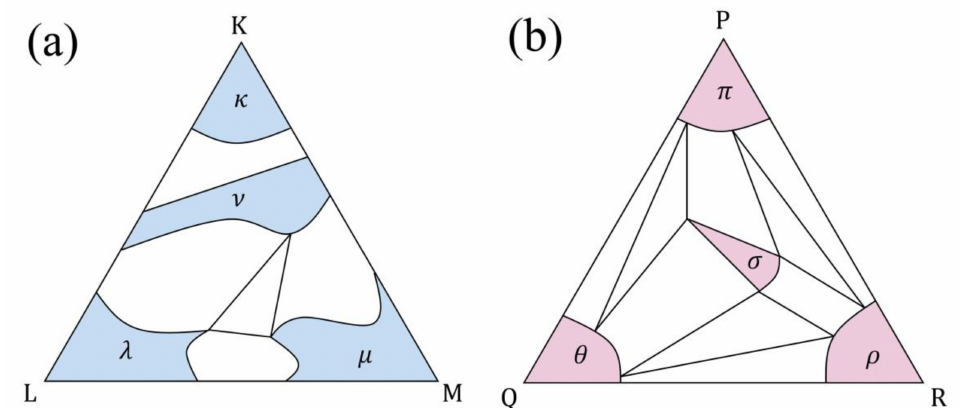
Figure 4. Imaginary phase diagrams illustrating the inheritance of IM phases in ternary systems. Colored areas represent single phase regions. ( a ) A phase inherited from two binary subsystems (the ν phase); ( b ) A phase that is original to the ternary systems (the σ phase). However, there are cases where the IM phase cannot be found in any of the binary subsystems. Therefore, the IM phase is not inherited and is original to the ternary